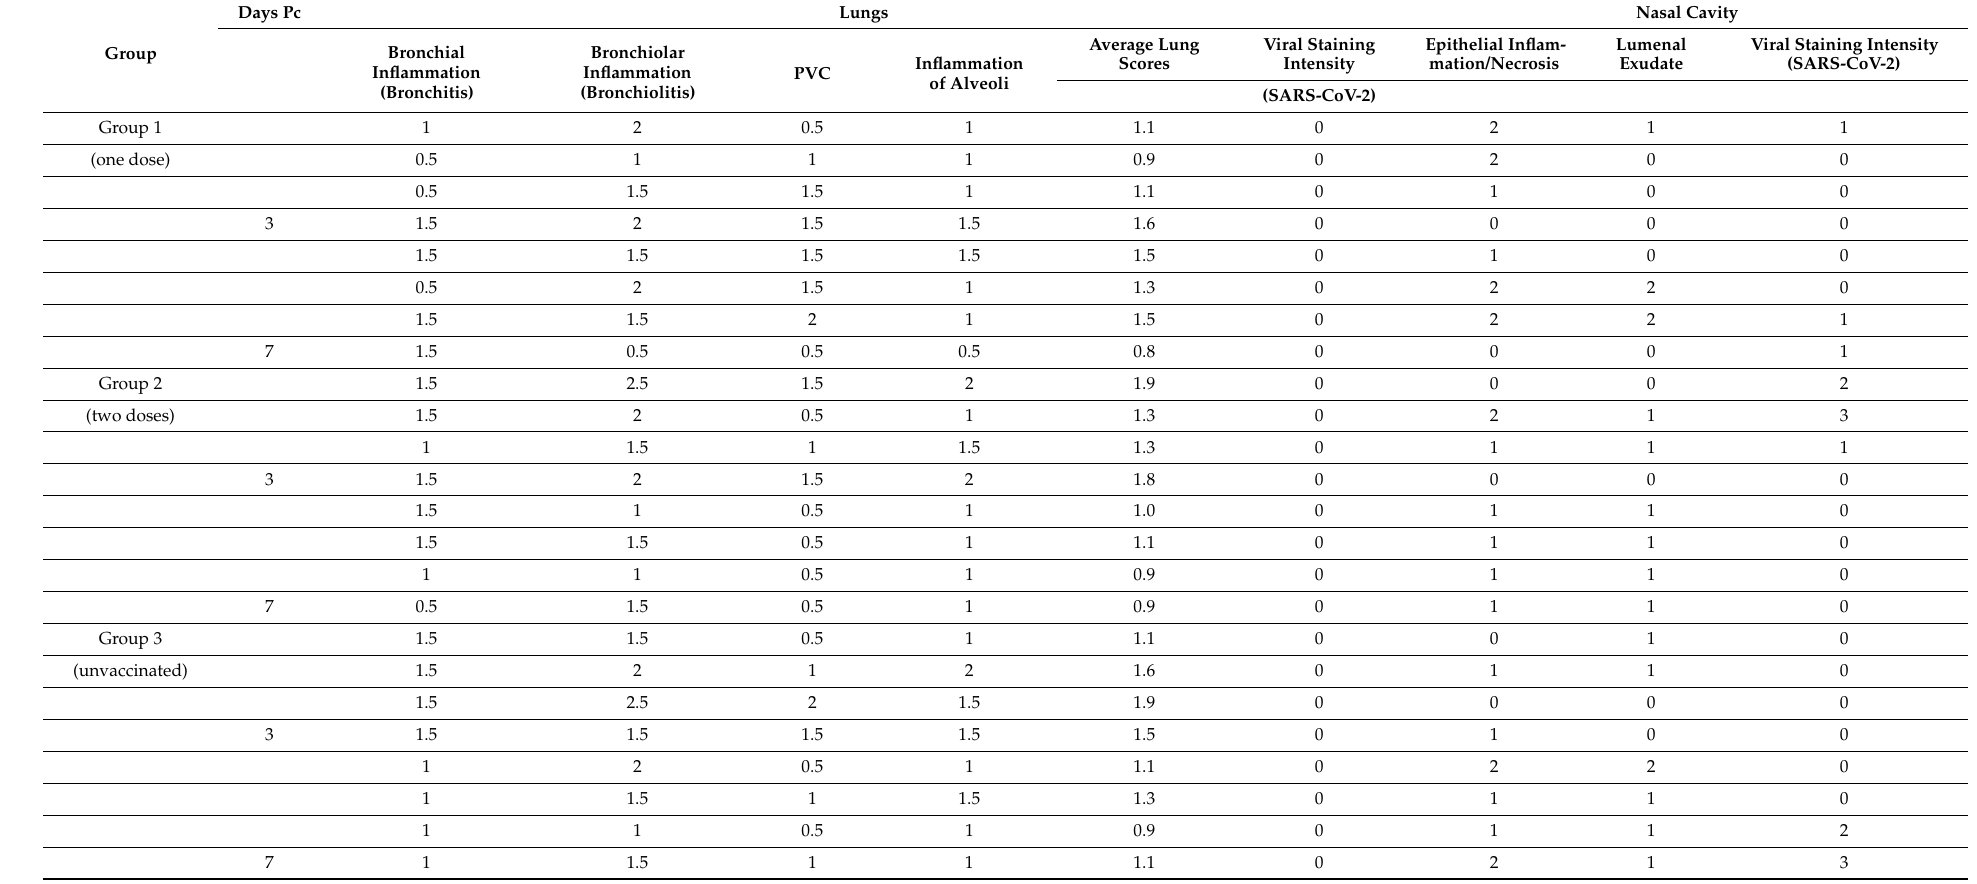
Table 2. Severity scores for lesions and the presence of viral staining in the lungs and nasal